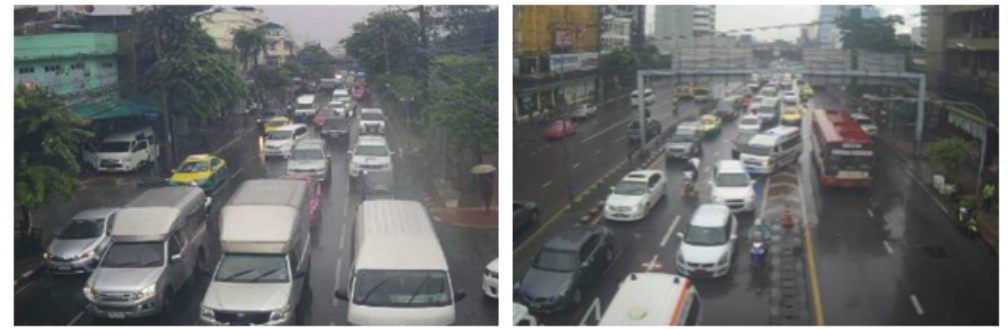
Figure 1. CCTV scene showing various events: raining, crowded traffic, and wet